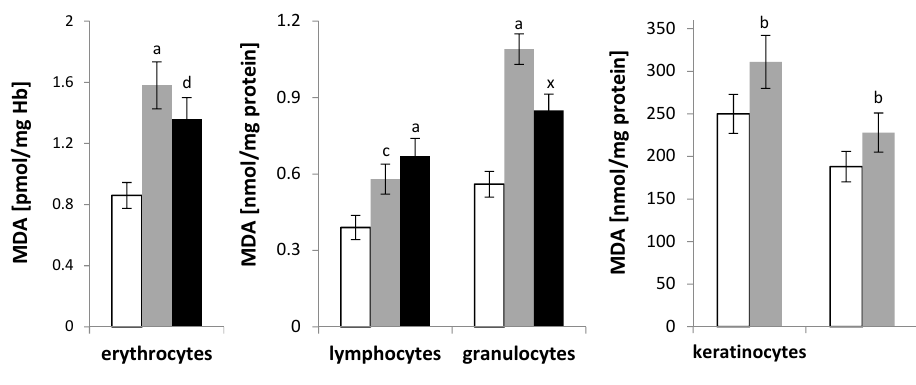
Figure 2. The level of lipid peroxidation product (malondialdehyde (MDA)) in blood cells (erythrocytes, lymphocytes and granulocytes) as well as skin cells (keratinocytes and fibroblasts) of patients with psoriasis vulgaris ( n = 16) and psoriatic arthritis ( n = 8) as well as healthy subjects ( n = 8). Data points represent the mean ± SD; a—statistically significant di ff erences vs. healthy subjects, p < 0.0001; b—statistically significant di ff erences vs. healthy subjects, p < 0.001; c—statistically significant di ff erences vs. healthy subjects, p < 0.01; d—statistically significant di ff erences vs. healthy subjects, p < 0.05; x—statistically significant di ff erences vs. patients with psoriasis vulgaris, p < 0.05